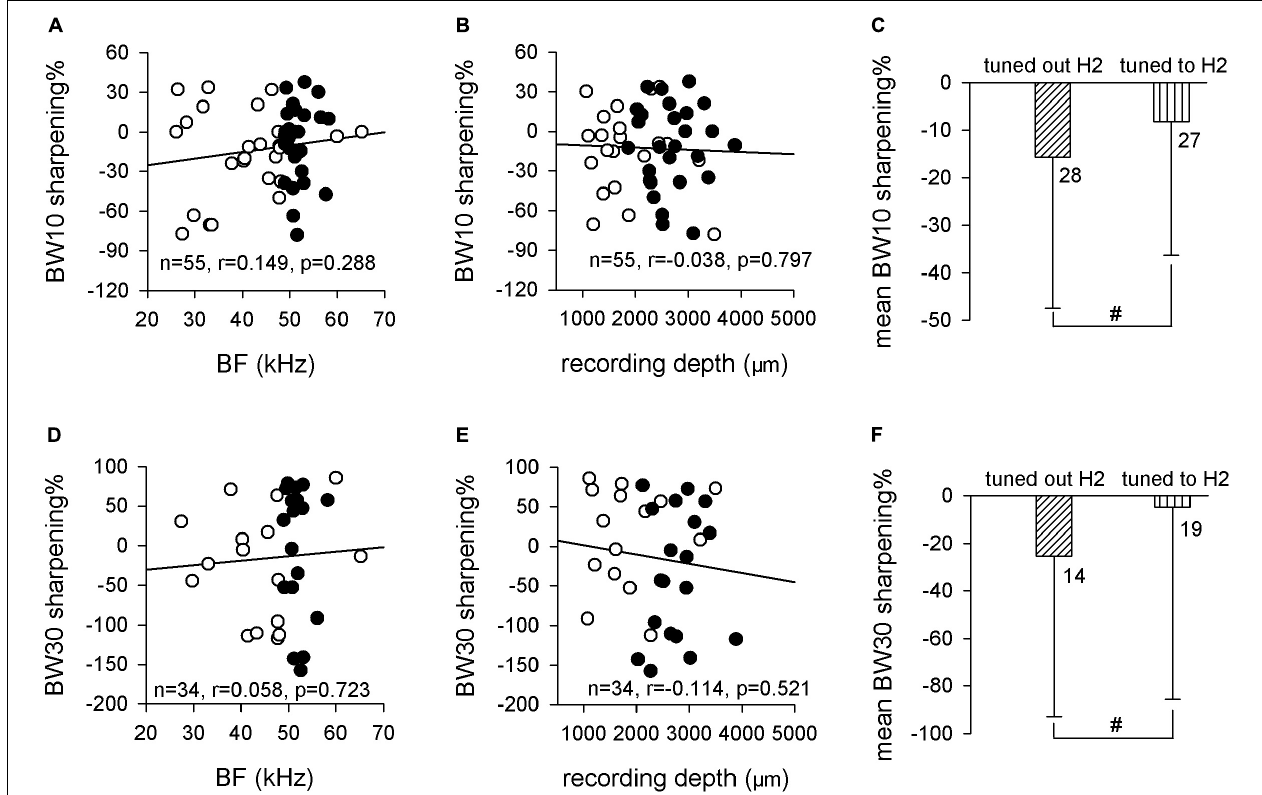
FIGURE 6 | The relationship between BW sharpening% and neuron’s BF or recording depth. (A,B) The distribution of BW10 sharpening% against BF (A) and recording depth (B) . Linear-regression analysis did not indicate any significant correlation. (C) Comparison of the mean BW10 sharpening% between neurons that tuned out H2 and neurons that tuned to H2. (D,E) The distribution of BW30 sharpening% against BF (D) and recording depth (E) . Linear-regression analysis did not reveal any significant correlation. (F) Comparison of the mean BW30 sharpening% between neurons that tuned out H2 and neurons that tuned to H2. Filled circle, neurons tuned to H2; unfilled circle, neurons tuned out H2. # p >